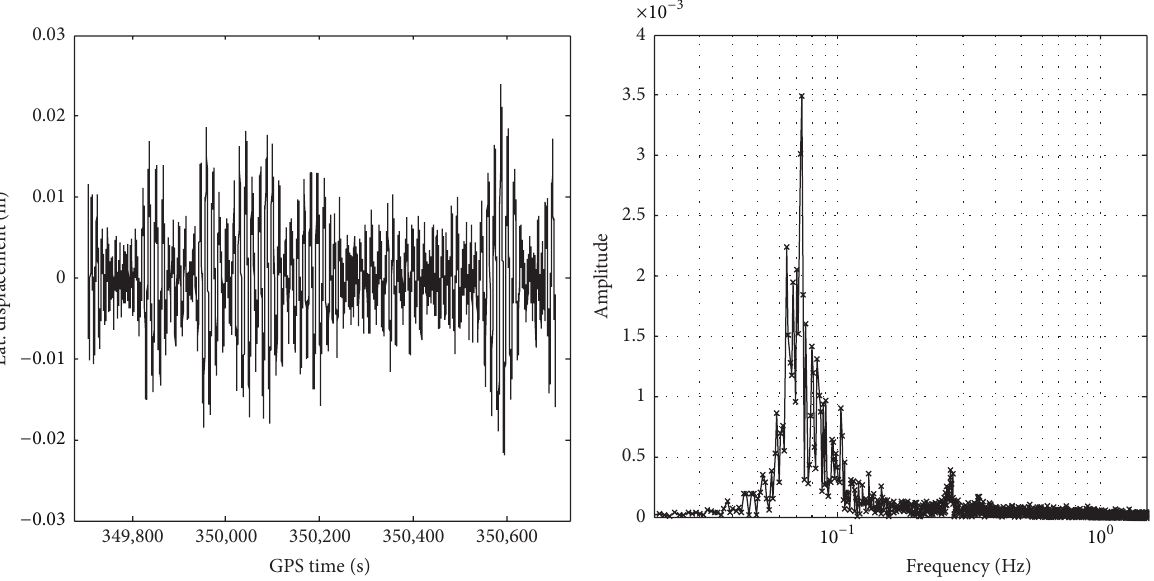
Figure 23: The filtered lateral displacements and corresponding frequencies.